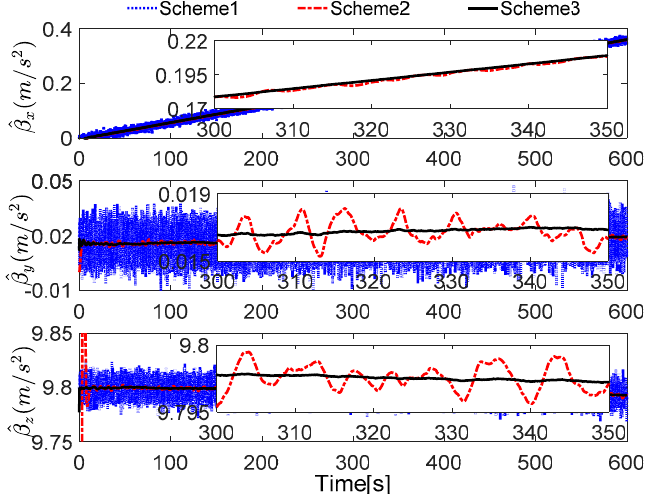
Figure 7. Curves of the reconstructed observation vectors.